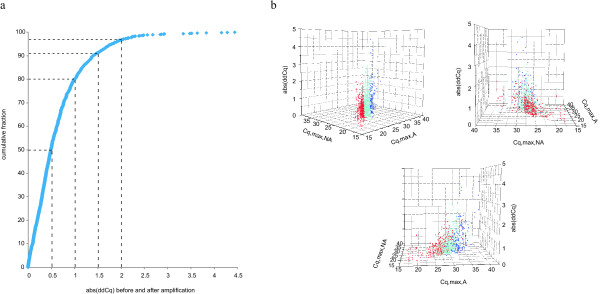
Unbiased pre-amplification procedure. a/Cumulative distribution plot of the absolute difference in delta-Cq-values (delta-delta-Cq or ddCq) before and after pre-amplification for 194 genes (12 reference genes and 182 targets of interest) in 100% Universal Human Reference RNA (UHRR) versus 100% Human Brain Reference RNA (HBRR) versus (25% UHRR + 75% HBRR) versus (75% UHRR + 25% HBRR). Each dot represents a ddCq-value between 2 samples before and after pre-amplification (in total 1164 data points). b/Three-dimensional representation of the ddCq (z-axis) versus the highest Cq-value amongst 4 values (2 replicates each of the 2 samples being compared before pre-amplification (Cq, max, NA: x-axis) and after pre-amplification (Cq, max, A: y-axis)). The lower the gene is expressed (high Cq-value), the higher the ddCq. Red dots: Cq, max, A - Cq, max, NA ≤ 2. Light blue dots: Cq, max, A - Cq, max, NA > 2; ≤ 5. Dark blue dots: Cq, max, A - Cq, max, NA > 5.